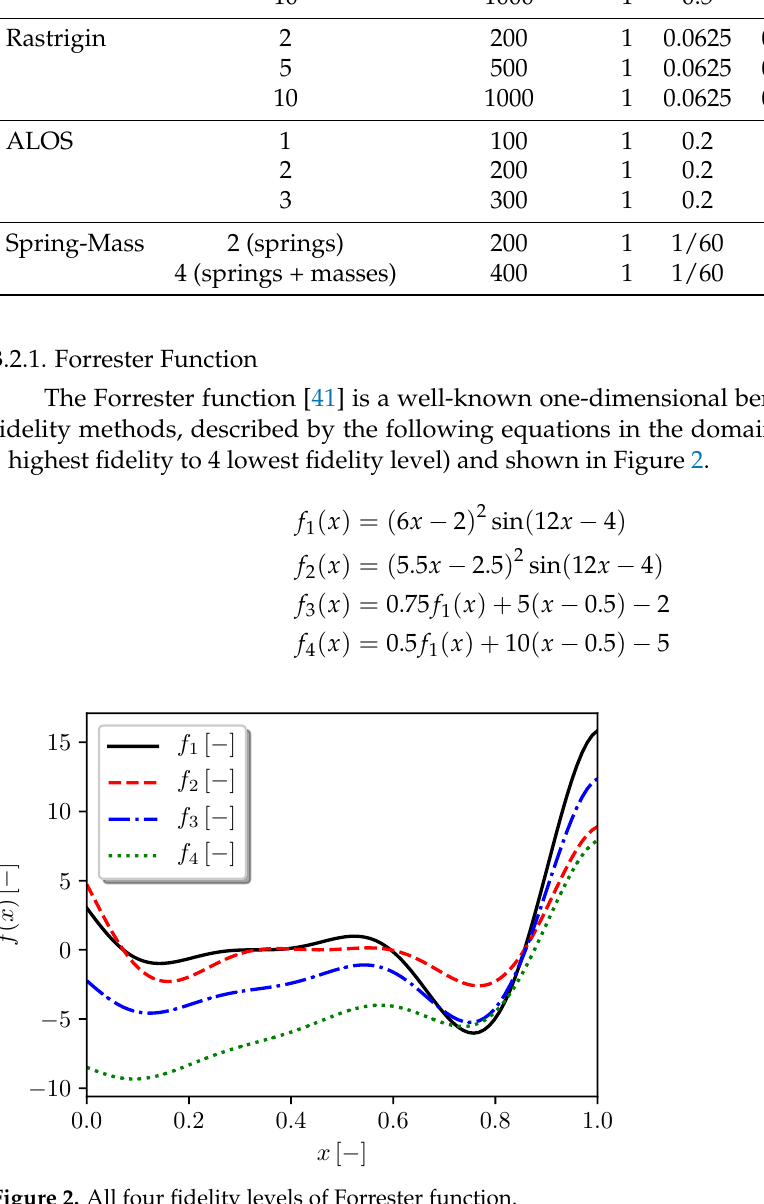
Figure 2. All four fidelity levels of Forrester